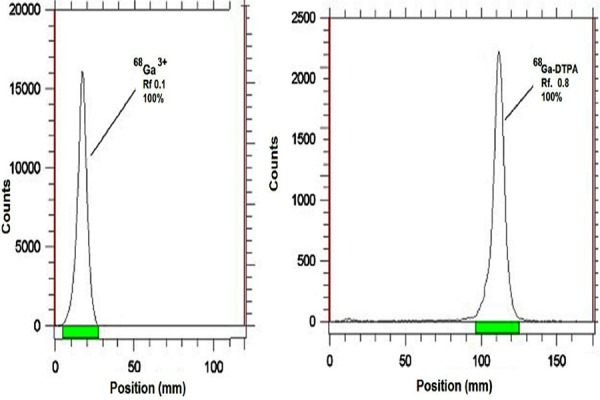
ITLC chromatogram of 68GaCl3 solution in DTPA (pH=5) (right) and 10% ammonium acetate: methanol (1:1) (left) using Whatman No. 2.